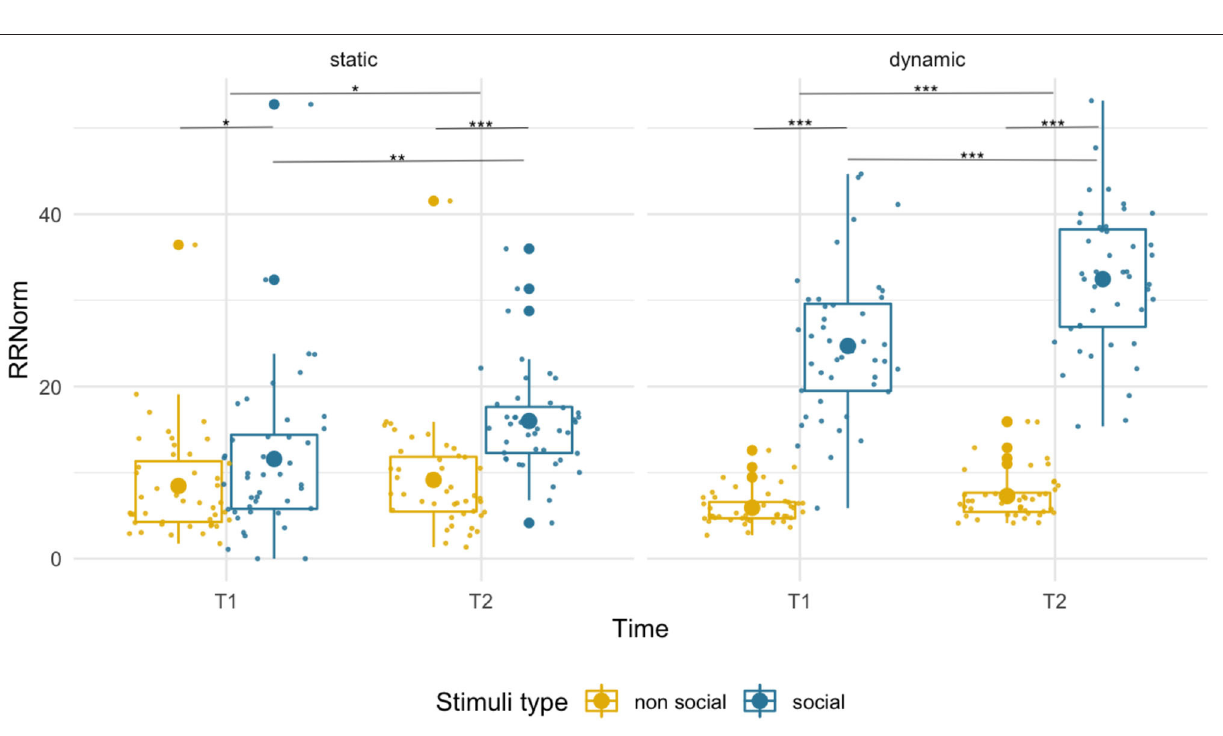
FIGURE 2 | Box plots with individual data showing distribution of normalized recurrence rate for each stimulus type. The big dot inside each box indicates the mean value. Significant differences marked with asterisks: * p < 0.05; ** p < 0.01; *** p <